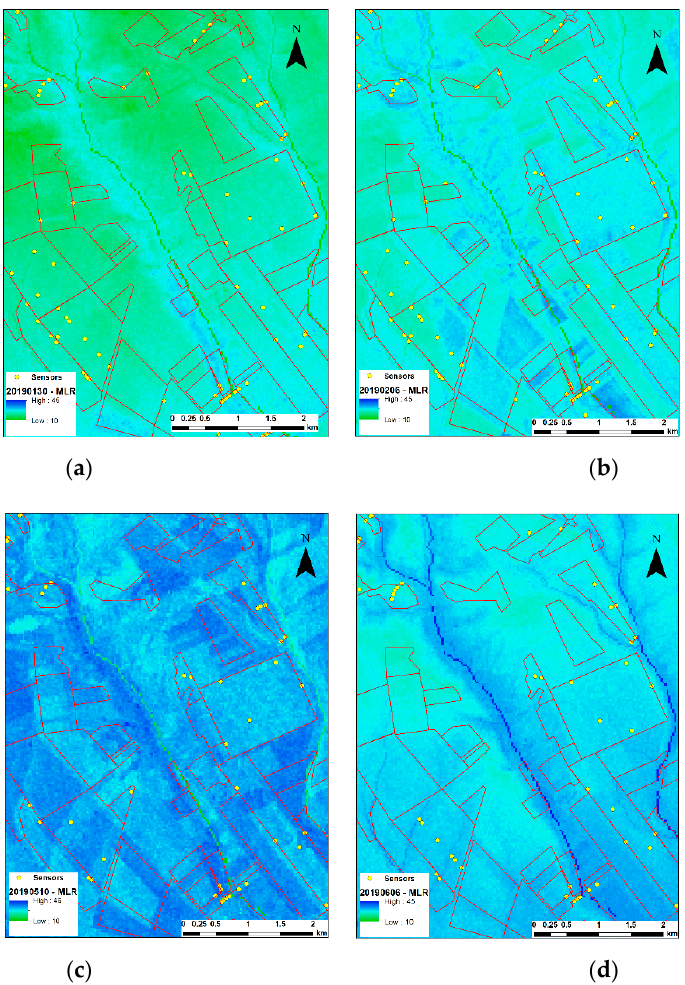
Figure 7. All land use: Predicted soil moisture maps (V%)—( a ) January 2019, ( b ) February 2019, ( c ) May 2019, and ( d ) June 2019, respectively.